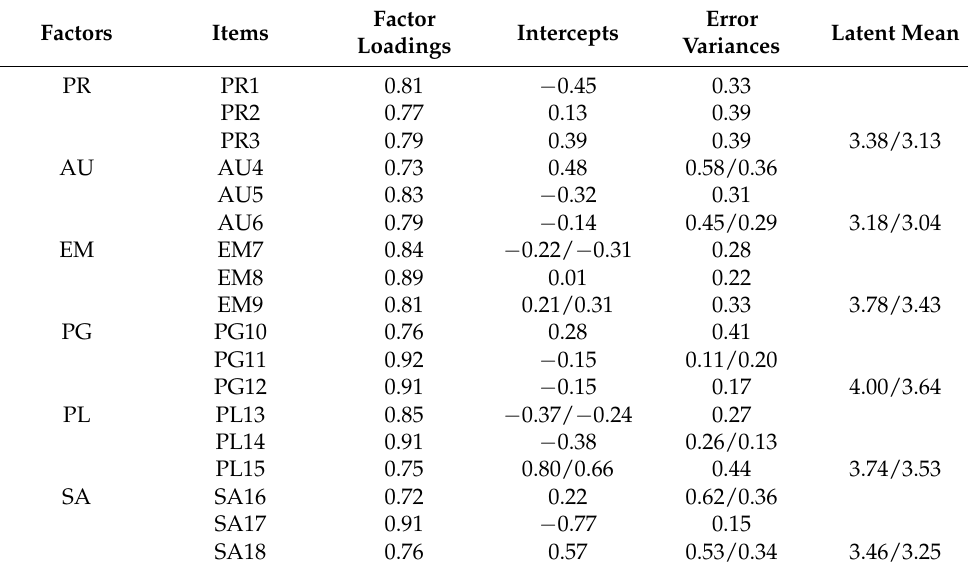
Table 3. Invariant and noninvariant factor loadings, intercepts, error variances, and mean differences between women with and without breast cancer.